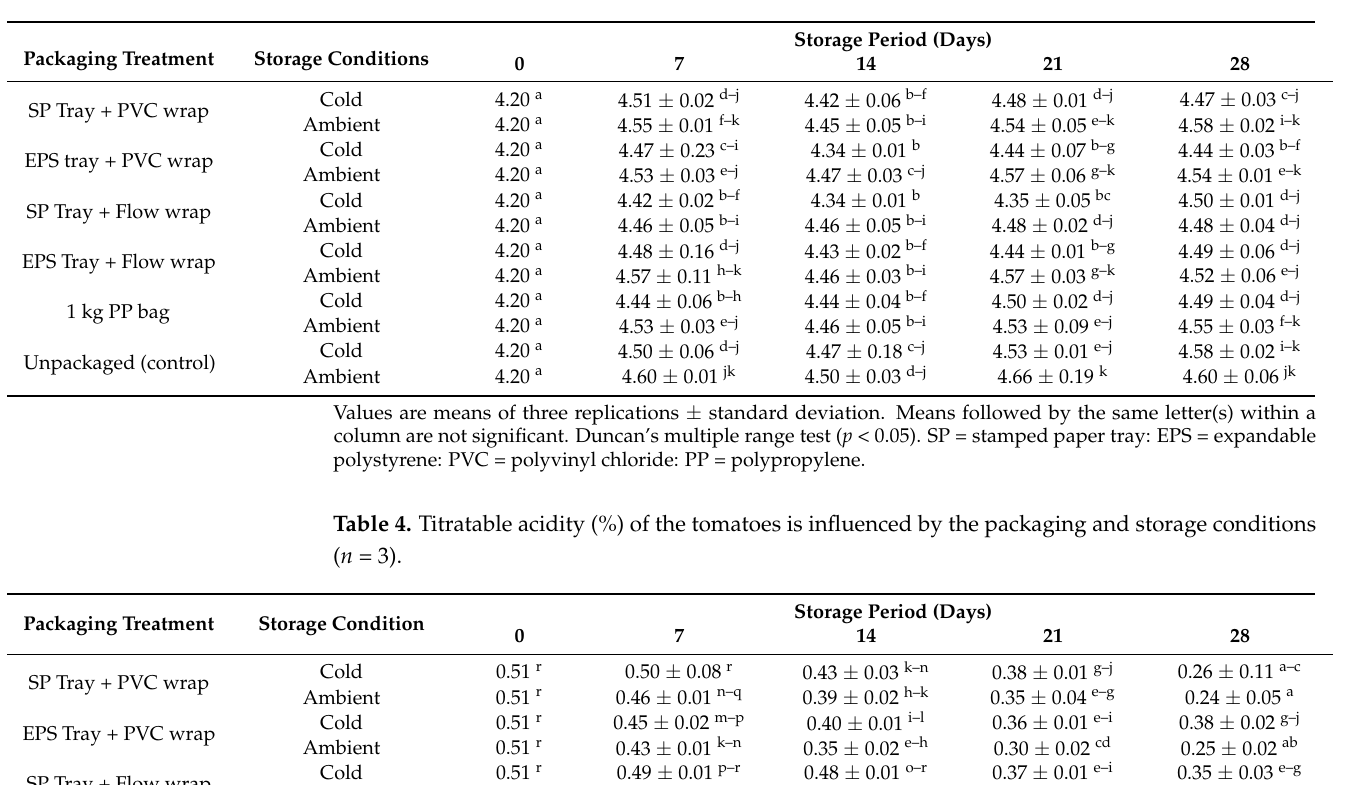
Table 3. pH values of the tomatoes affected by the packaging and storage conditions during storage ( n = 3).